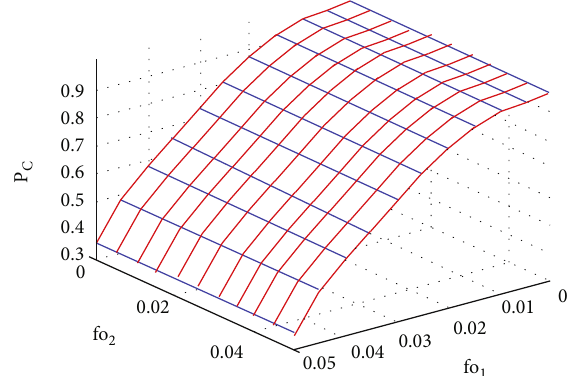
0.040.02 fo 2 Figure 7: The in fl uence of frequency o ff set on the algorithm for joint recognition of interference.